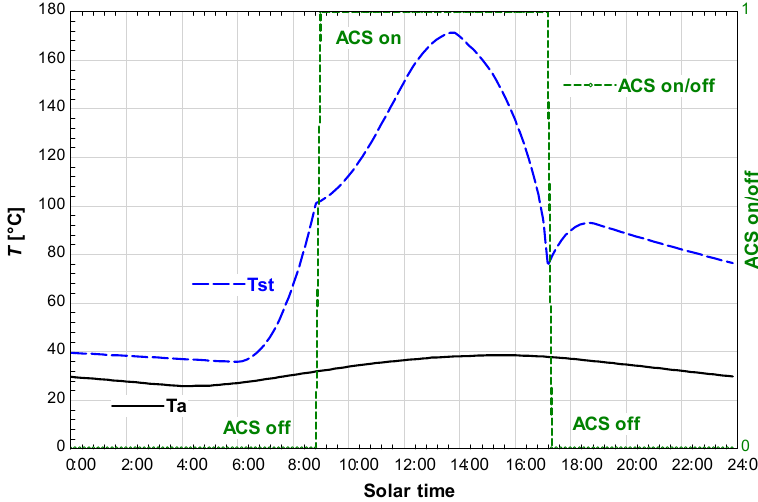
Figure 7. Ambient and storage tank fluid temperatures on working and non-working periods of the ACS; case study 10 m PTC, 0.16 m 3 water storage tank.